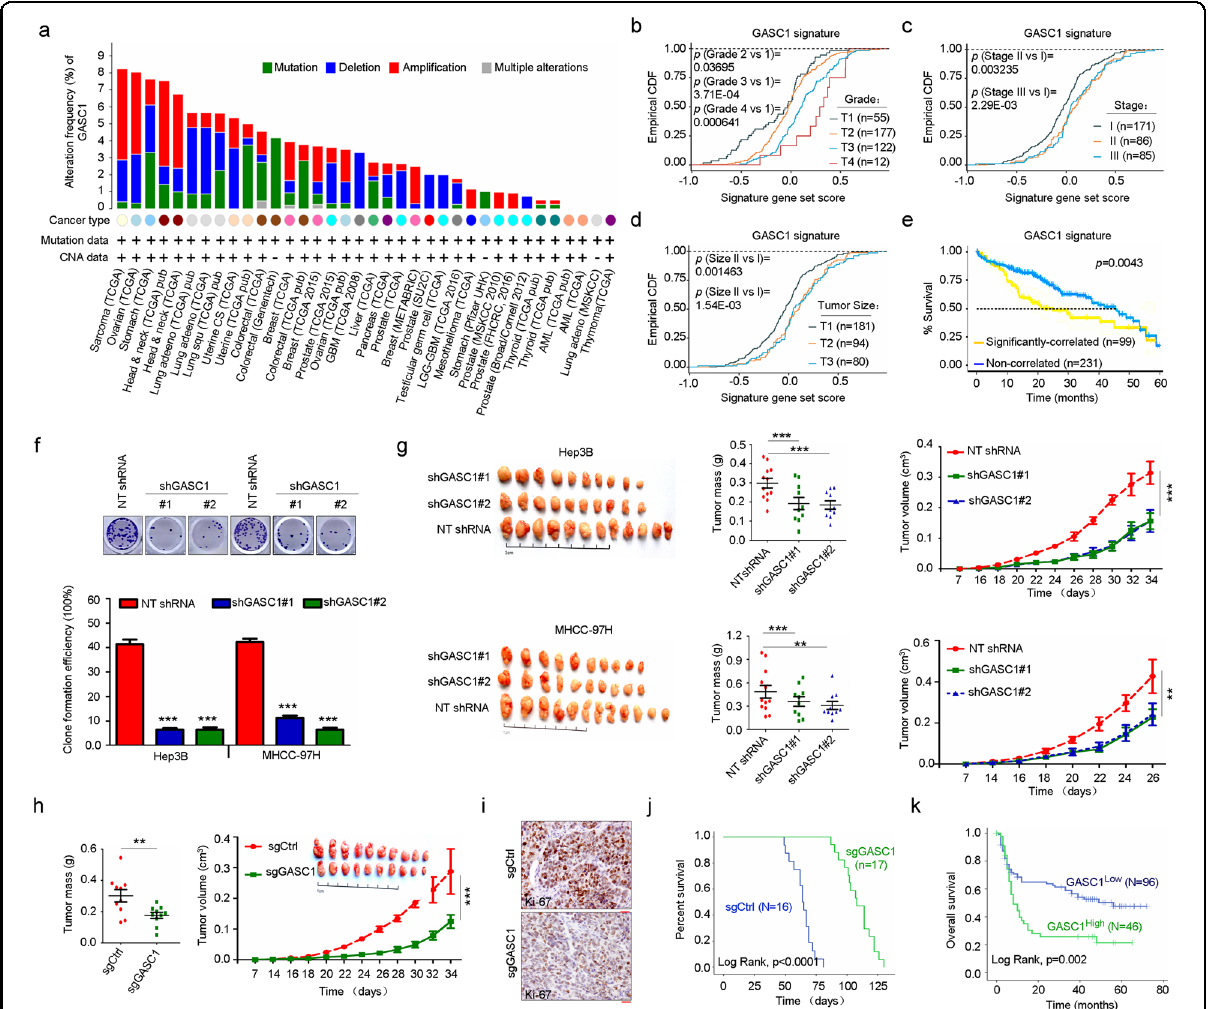
Fig. 1 Depletion of GASC1 suppresses HCC proliferation and tumor growth. a Distribution of alteration frequency in GASC1 gene in multiple cancer types. Details of the corresponding tumor data set and the year of publication were indicated in parentheses. CNA copy-number alteration. b Empirical cumulative distribution function (CDF) plots showing correlation of individual tumors with GASC1 signature across various tumor grades within the HCC cohort. c CDF plots showing correlation of individual tumors with GASC1 signature across various clinical stages within the HCC cohort. d CDF plots showing correlation of individual tumors with GASC1 signature across various tumor size within the HCC cohort. e Kaplan – Meier survival curves comparing subjects in the TCGA HCC cohort strati fi ed by correlation with GASC1 signature. Tumor samples were binned according to their gene expression correlation with GASC1 signature. Subjects harboring the top 30% ( n = 99) most correlated tumors exhibited signi fi cantly decreased survival as compared to the remaining subjects ( n = 231) from the TCGA HCC cohort. f Ef fi ciency of colony-formation was examined in GASC1 shRNA (shGASC1) and Non-targeting shRNA (NT) treated Hep3B and MHCC-97H cells 2 – 3 weeks after plating. Data are presented as mean